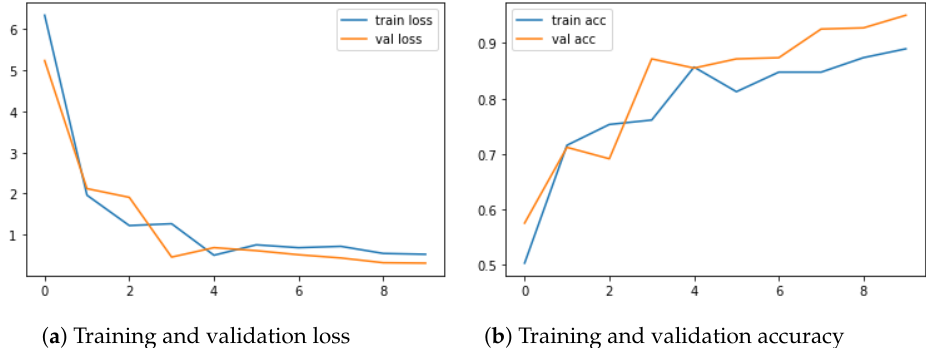
Figure 3. Classification performance of the Inception v3 model on a